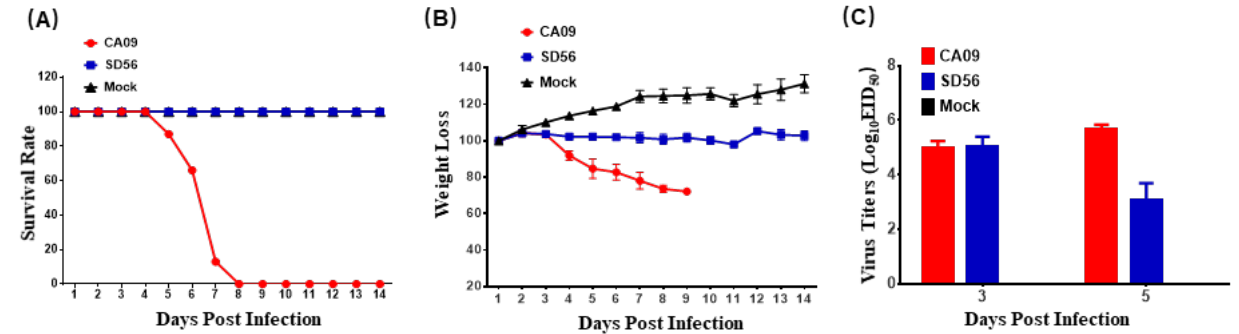
Figure 1. Pathogenicity of CA09 and SD56 in mice. Mice ( n = 12 per group) inoculated with CA09, SD56, or PBS were monitored for mortality and the change in body weights for 14 days (once per day) after infections. ( A ) The survival rates of the infected mice. ( B ) The changes in body weights of the infected mice. ( C ) The lungs of each group were harvested at 3 and 5 dpi and the lung viral loads were titrated on SPF embryos.